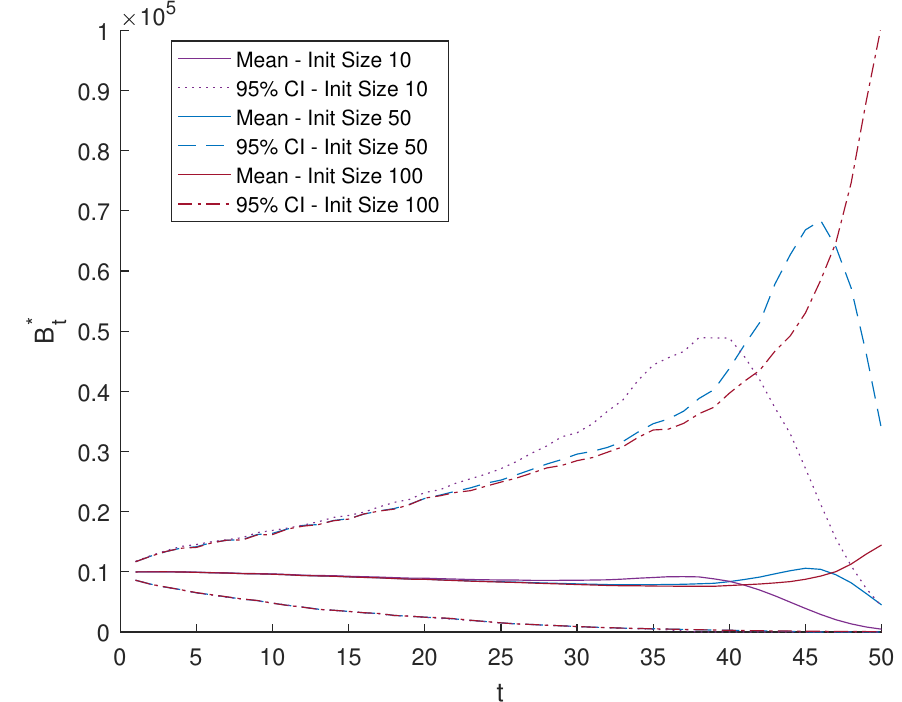
Figure 9. Initial Pool Size Comparison: 10 vs. 50 vs.